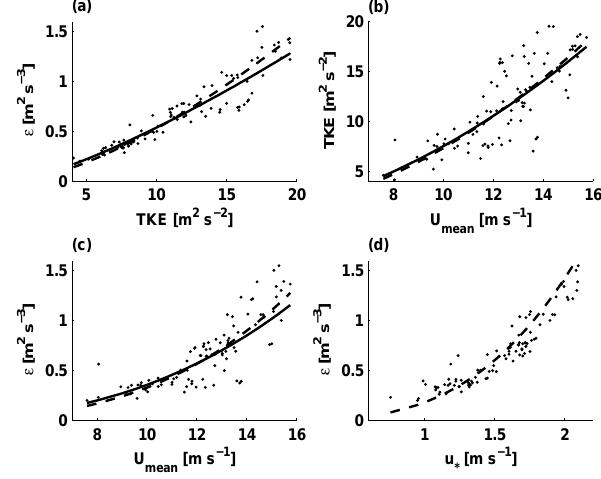
Fig. 8. Scatter plots of (a) ε vs. TKE, (b) TKE vs. U , (c) ε vs. U and (d) ε vs. u ∗ for the entire bora episode. Solid lines are fits with the a priori unknown coefficients a and b from the relation (4b). Dashed lines are fits with the a priori known coefficient b t from the relation